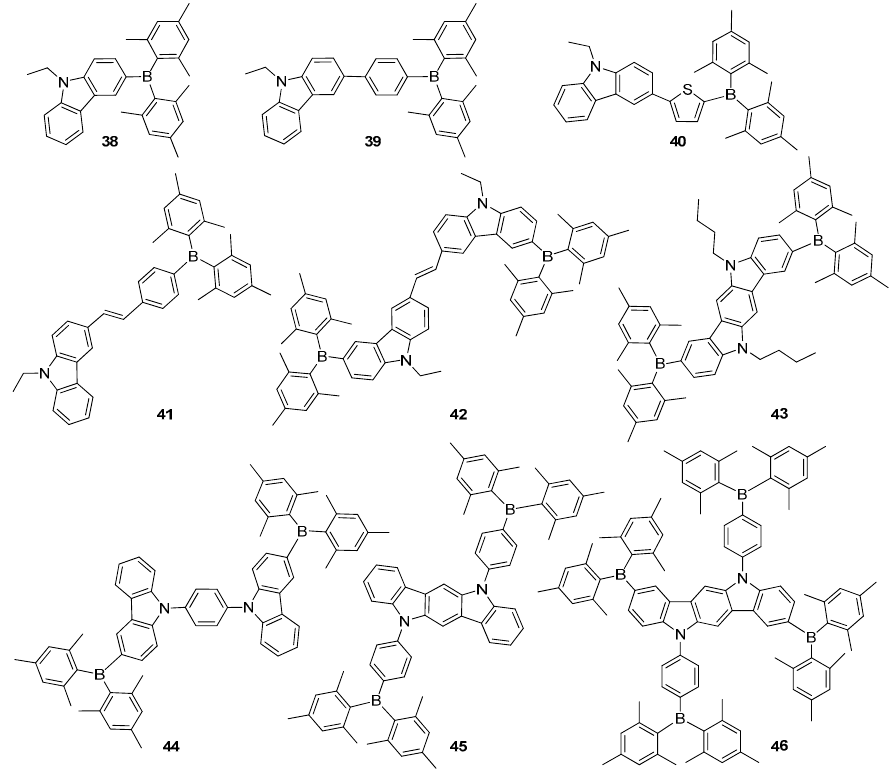
Figure 8. Carbazole possessing triarylborane-based materials 38 – 46 .